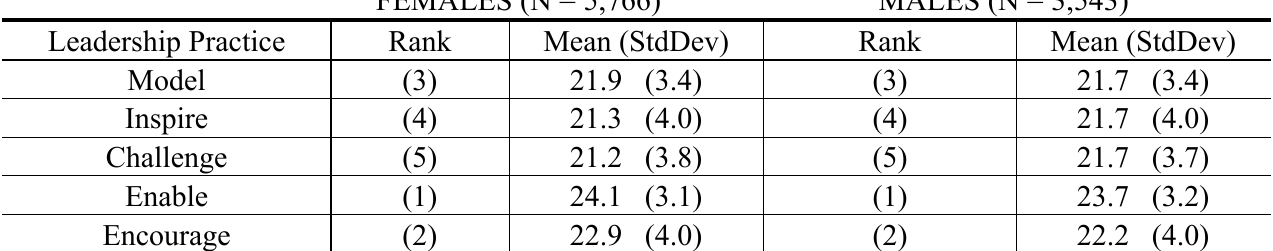
Table 3a. Comparisons Between Females and Males (Self).